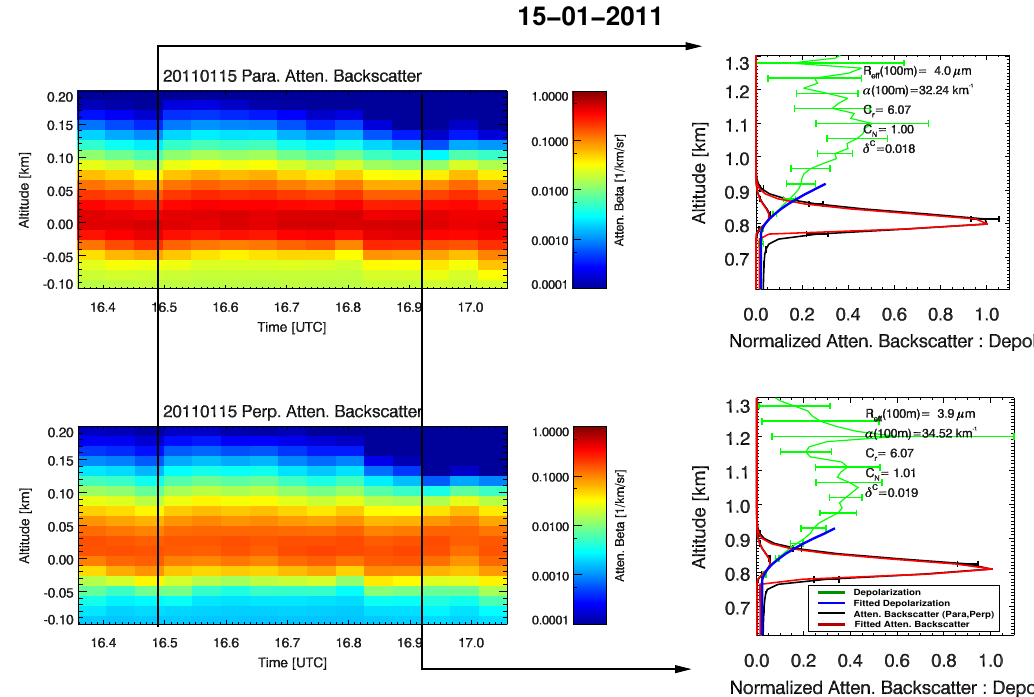
Figure 14. Normalised parallel and perpendicular attenuated backscatters as a function of altitude from the peak of the observed paral- lel backscatter profile (left panels) corresponding to the data shown in Fig. 13. Example fit results are shown on the right for 16.49 and